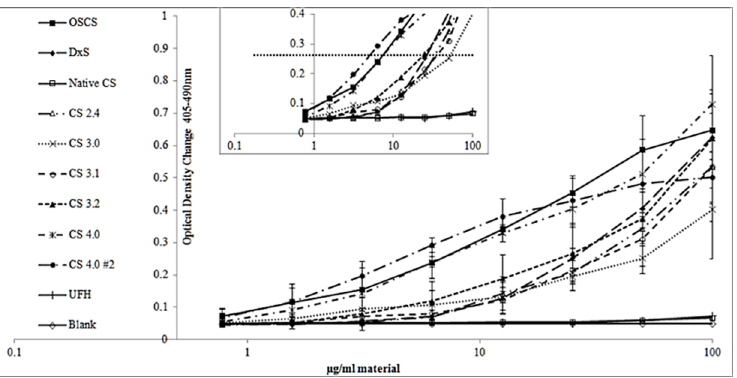
Fig 1. Kallikrein generation in normal pooled plasma by synthetic and purified OSCSs, native chondroitin sulfate, dextran sulfate and unfractionated heparin. Error bars = standard deviations (SD), n = 6, note lines for native CS, unfractionated heparin and plasma alone are overlapping. Inset chart shows line ( ... . ) indicating Δ 0.2 OD above baseline used to select concentration of samples for the bradykinin